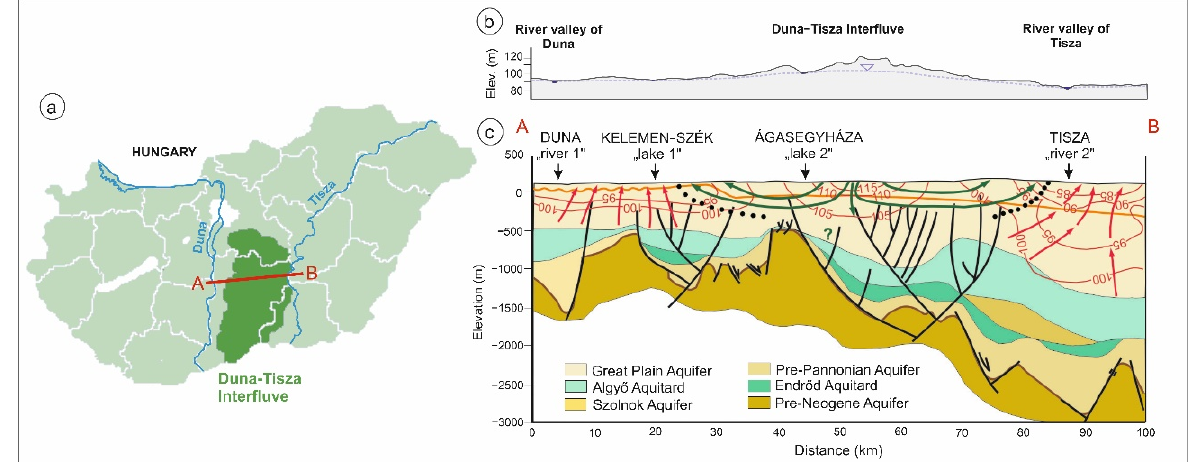
Figure 1. ( a ) Location of the Duna-Tisza Interfluve in Hungary, with the track of studied cross section AB, ( b ) topography and groundwater table configuration, ( c ) hydrostratigraphic and hydraulic conditions along the cross section based on Mádl-Sz ő nyi and Tóth [27]. Red lines with numbers (m asl) represent equipotential lines obtained from detailed regional hydraulic evaluation of the Interfluve. Green arrows show flowlines of gravity-driven flow, while red arrows indicate upward compressional flow. Boundary between the two systems showed by dashed black line.